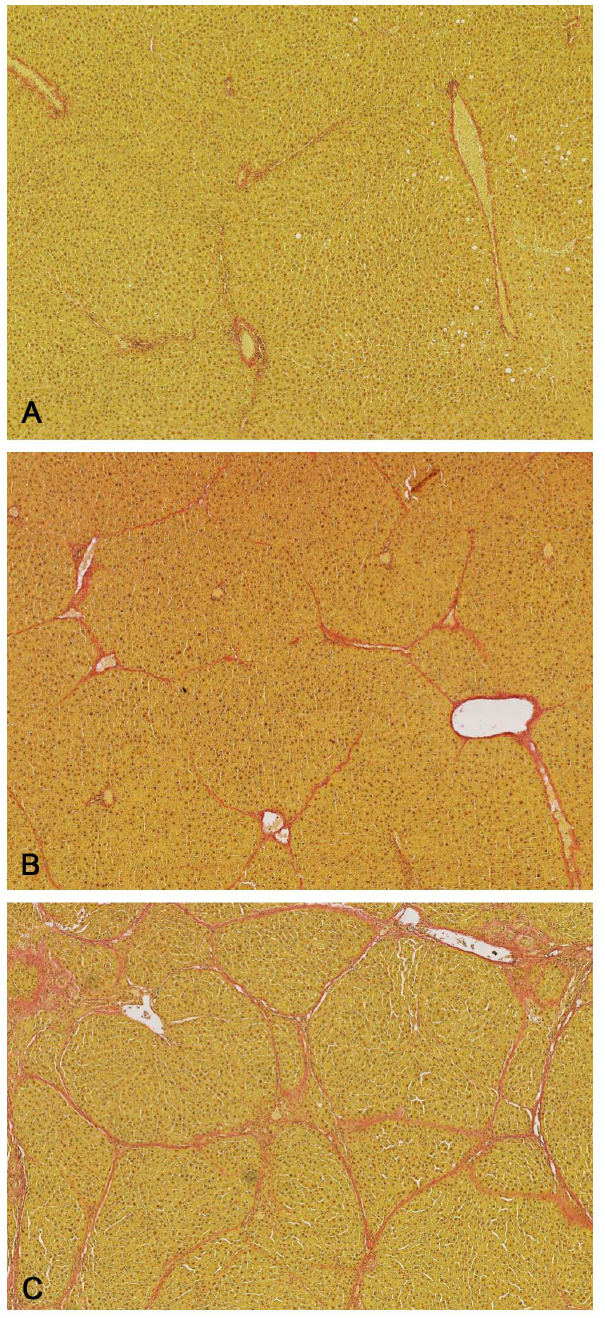
Figure 2. Histology of rat livers. Representative photomicrographs (Van Gieson stain, 50 6 magnification) of liver sections taken from an healthy (Ishak score=0) (A), a non-ascitic (Ishak score=4) (B), and an ascitic cirrhotic rat (Ishak score=6) (C).